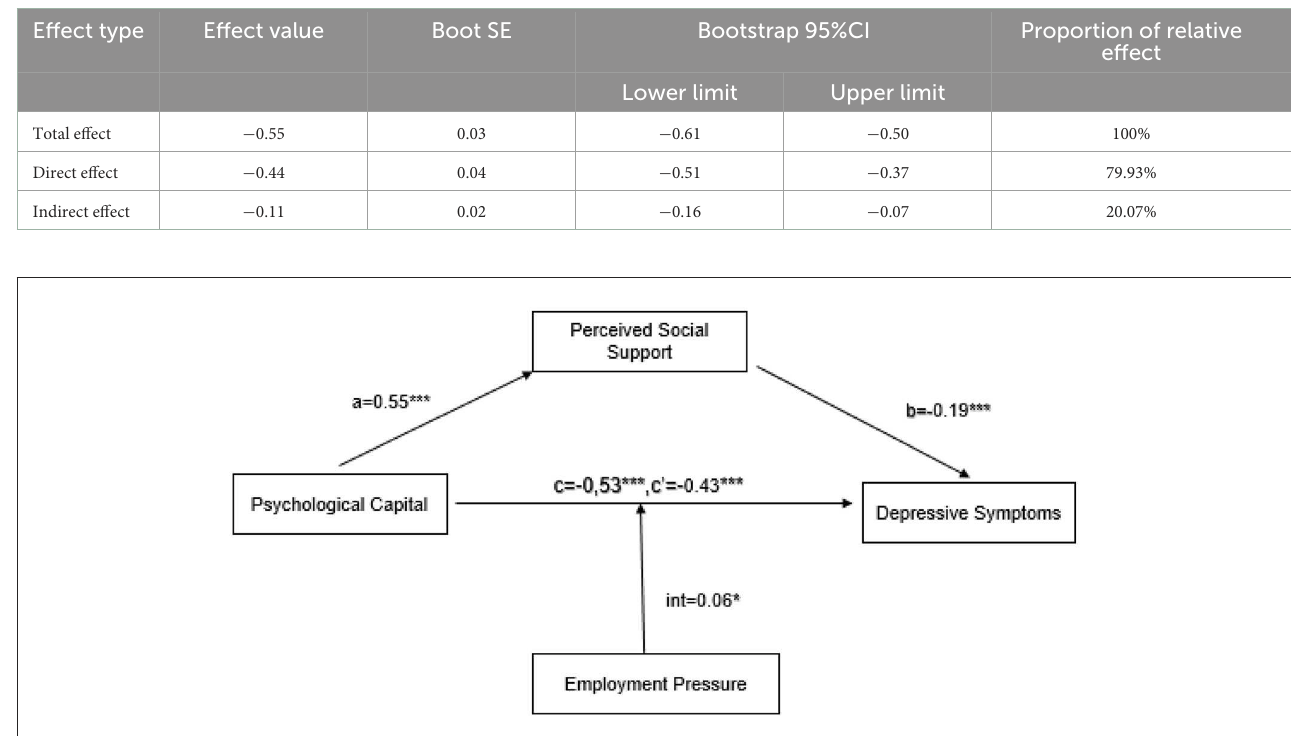
FIGURE1 The moderated mediation model. *** p < 0.001, * p <